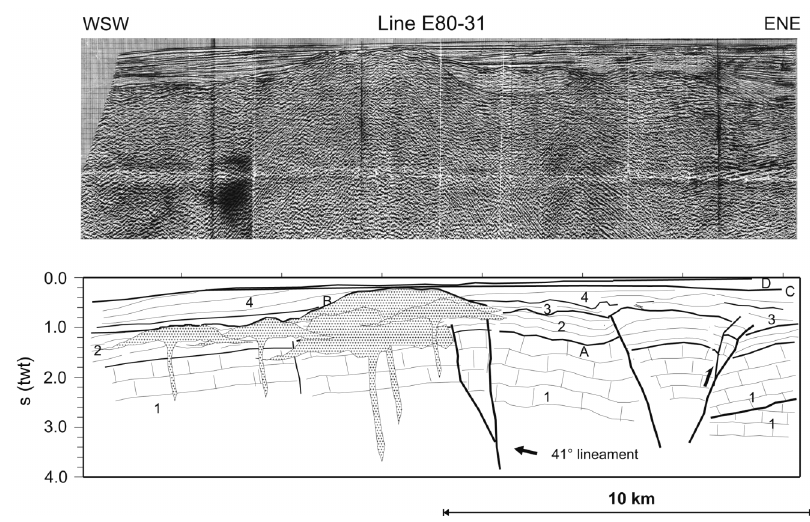
Fig. 4. E80-31 multichannel profile and interpretation. Location in fig. 2. Legenda as in fig.